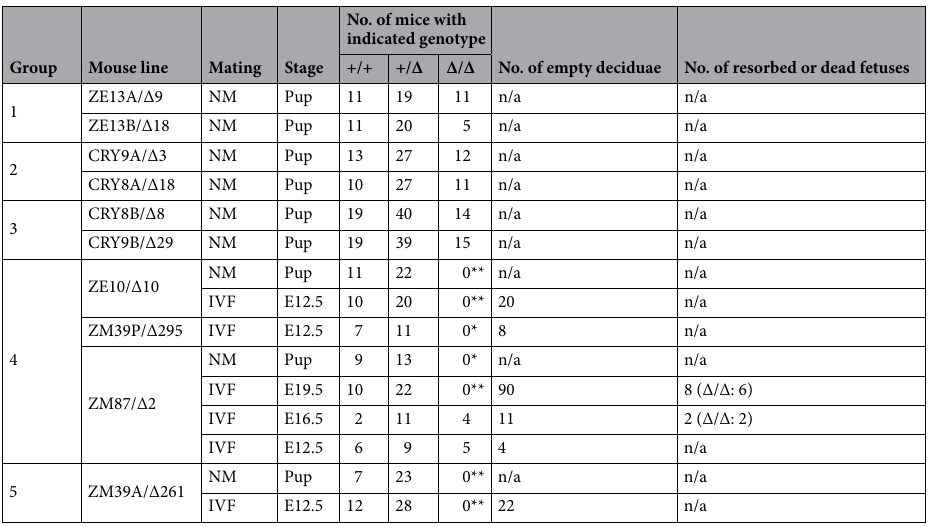
Table 1. Genotypes of offspring from heterozygous intercrosses. NM, natural mating. IVF, in vitro fertilization and embryo transfer. n/a, not applicable. * p < 0.05, ** p < 0.01 (chi-square